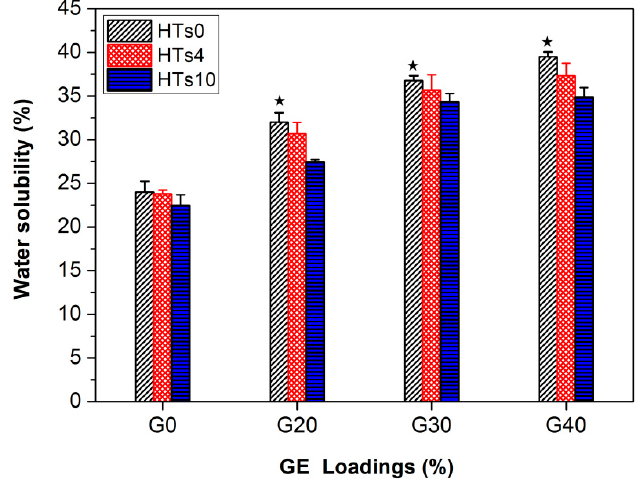
Figure 9. Water solubility of FG/GE/HT composites with various HT and GE loadings. * denotes significant difference between FG films containing different percentages of GE ( p < 0.05).